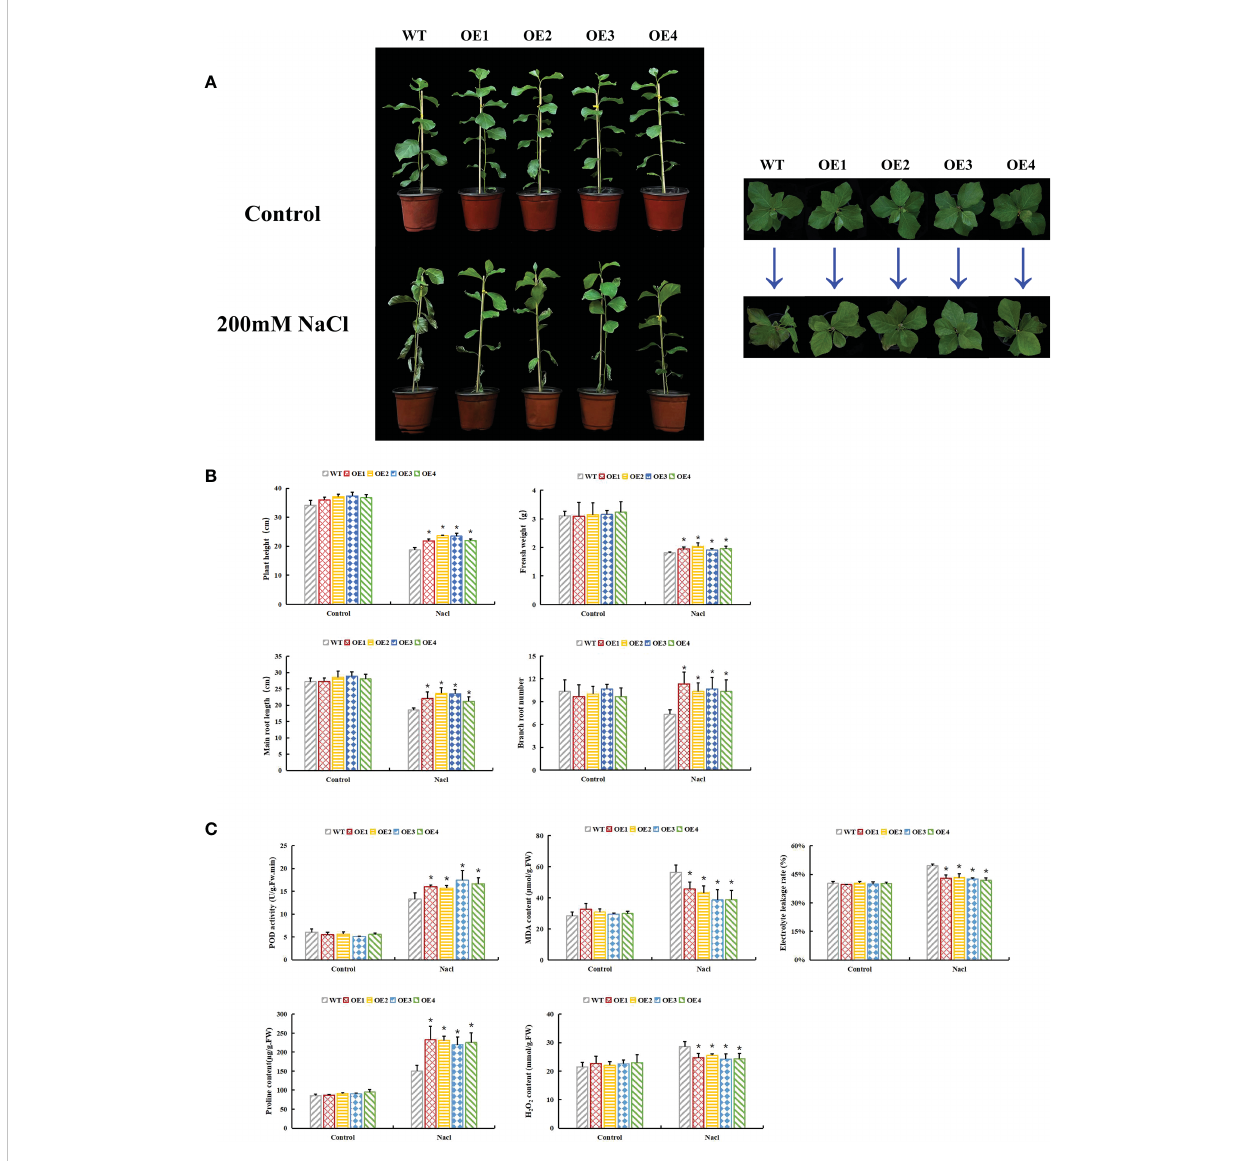
FIGURE 9 Functional analysis of PsnHSF21 under salt stress. The seedlings of WT and overexpressed PsnHSF21 poplar were stressed with water and 200 mM NaCl for 7 days. Control was water and treatment was 200 mM NaCl. (A) Display of the growth phenotype. (B) The growth index shows plant height, fresh weight, main root length, and lateral root number, three biological repeats. (C) Physiological index displays: POD, MDA, proline, electrical conductivity, and H 2 O 2 content, three biological repeats. The error line represents the standard deviation (SD) of biological replication. “ * ” indicates there is a signi fi cant difference (P